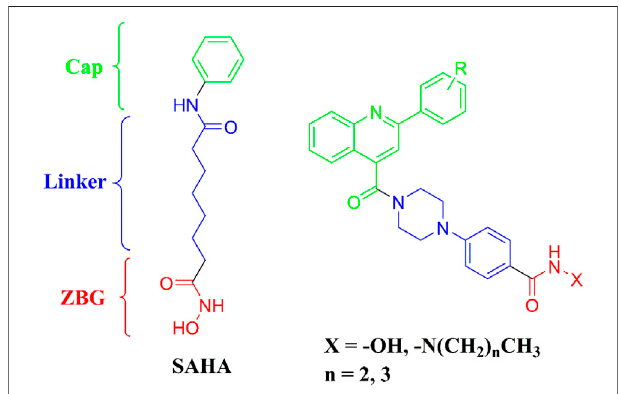
FIGURE 1 | Design of 2-substituted phenylquinoline-4-carboxylic acid bearing HDAC